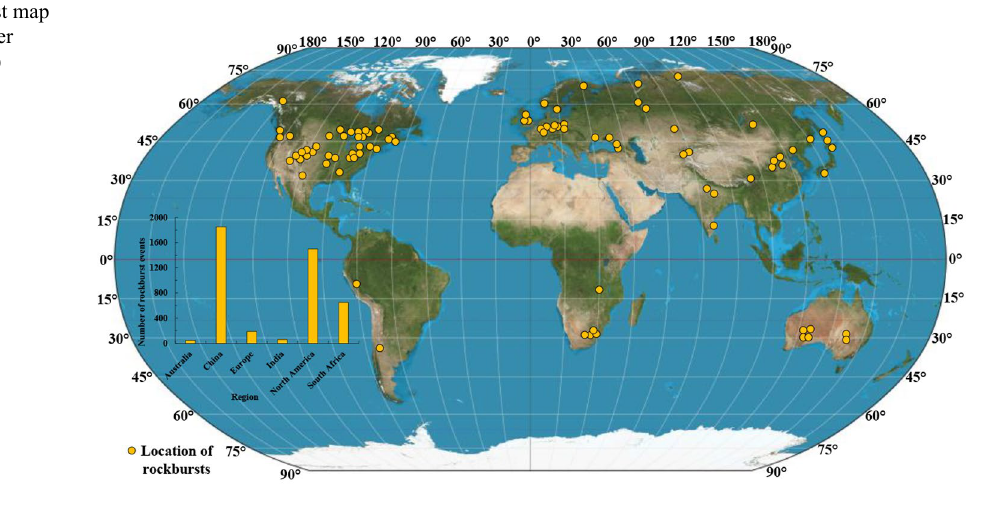
Fig. 1 A historical rockburst